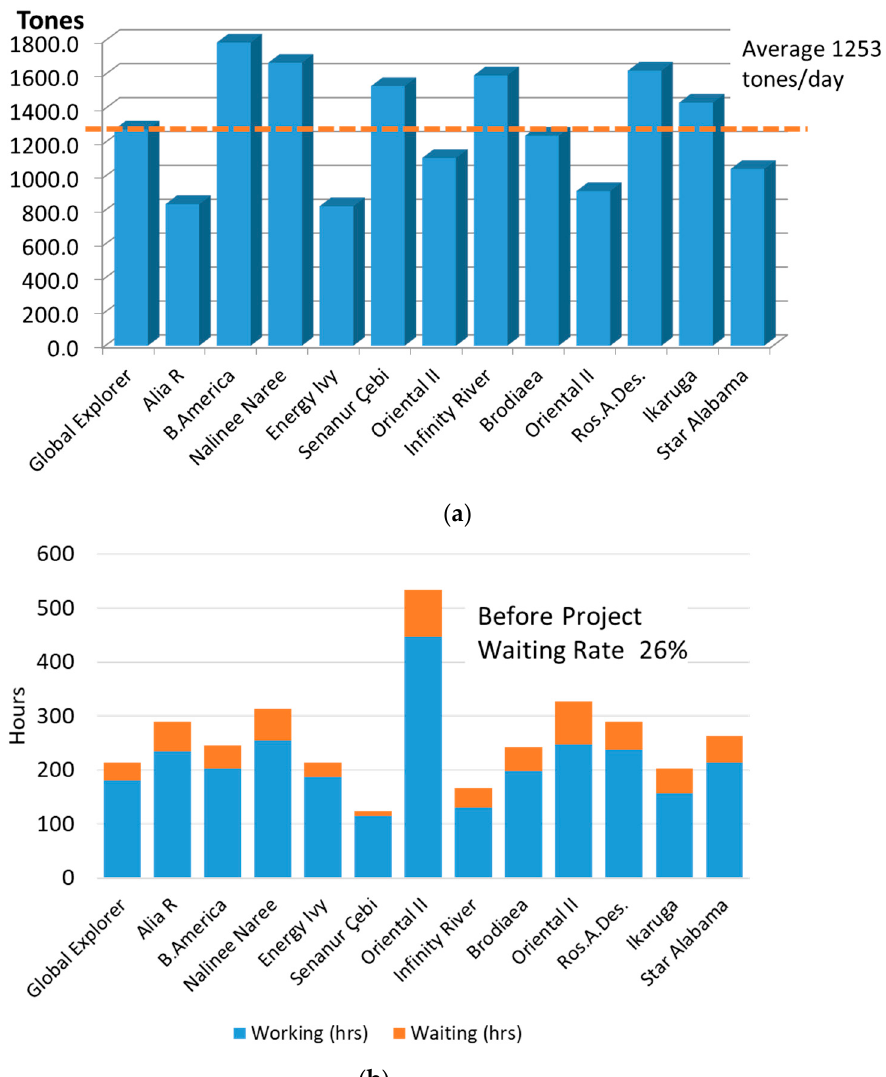
Figure 2. ( a ) Average daily loading rate (before) and ( b ) Average waiting rate (before).